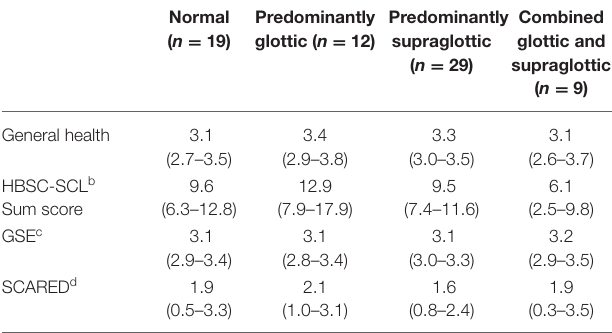
TABLE 5 | Scores on patient reported outcome measures of 69 participants a , split by the four types of exercise induced laryngeal obstruction (EILO); for details see text and Table 2